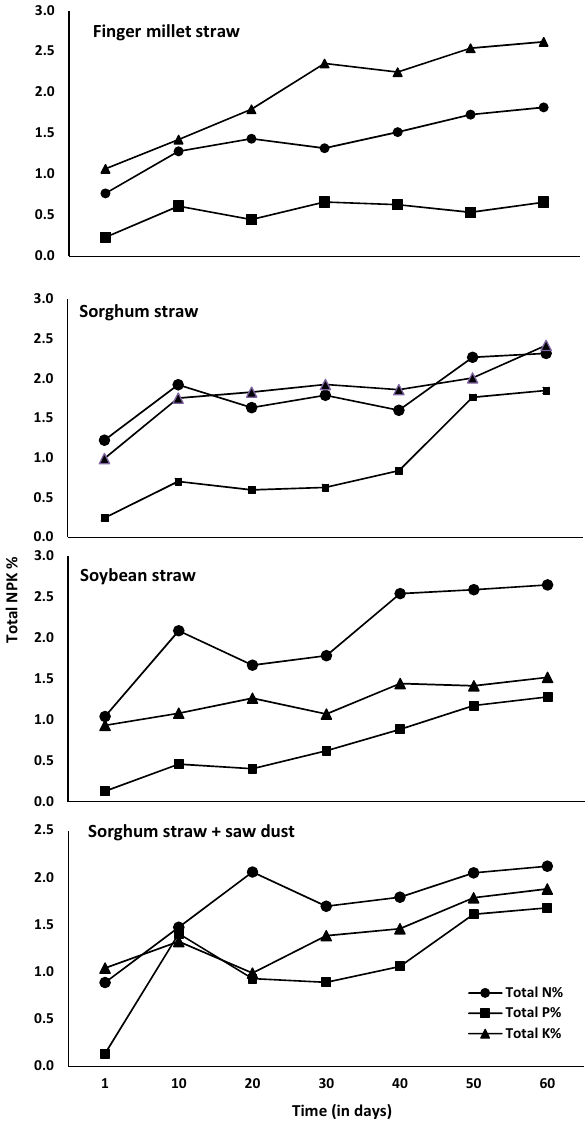
Fig. 4 NPK dynamics of the finger millet straw, sorghum straw, soy- bean straw and sorghum straw + saw dust during the composting pro-